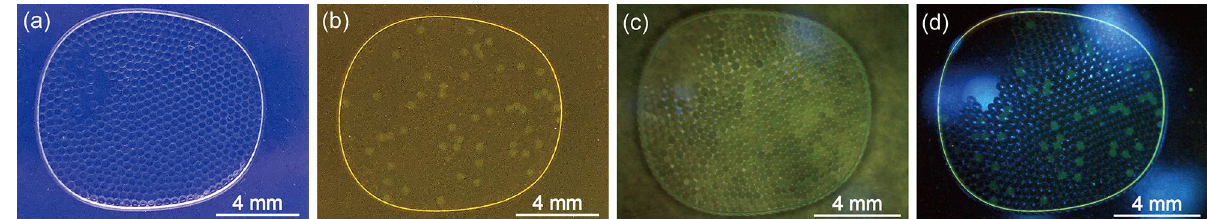
Figure 7. Imaging ddPCR droplets by smartphone together with transilluminator without ( a ) or with ( b ) fluorescence illuminating/filtering and by handheld mini microscope without ( c ) or with ( d ) fluorescence